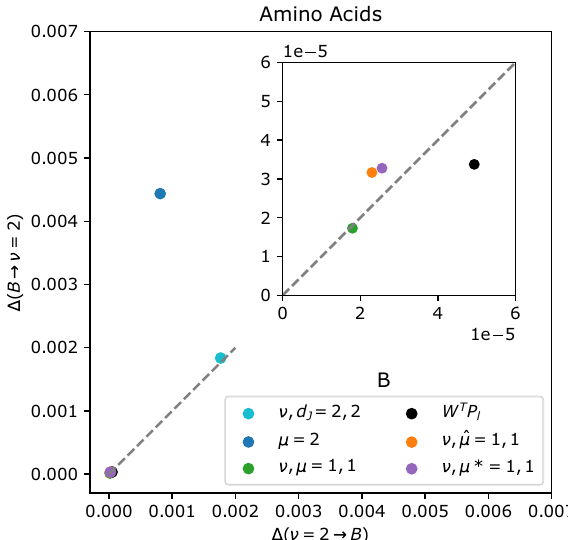
Fig. 5 Information imbalance plane for amino acids. Information imbalance plane for atomic environments in the amino acid dataset. The central atom was not included in the density expansion.